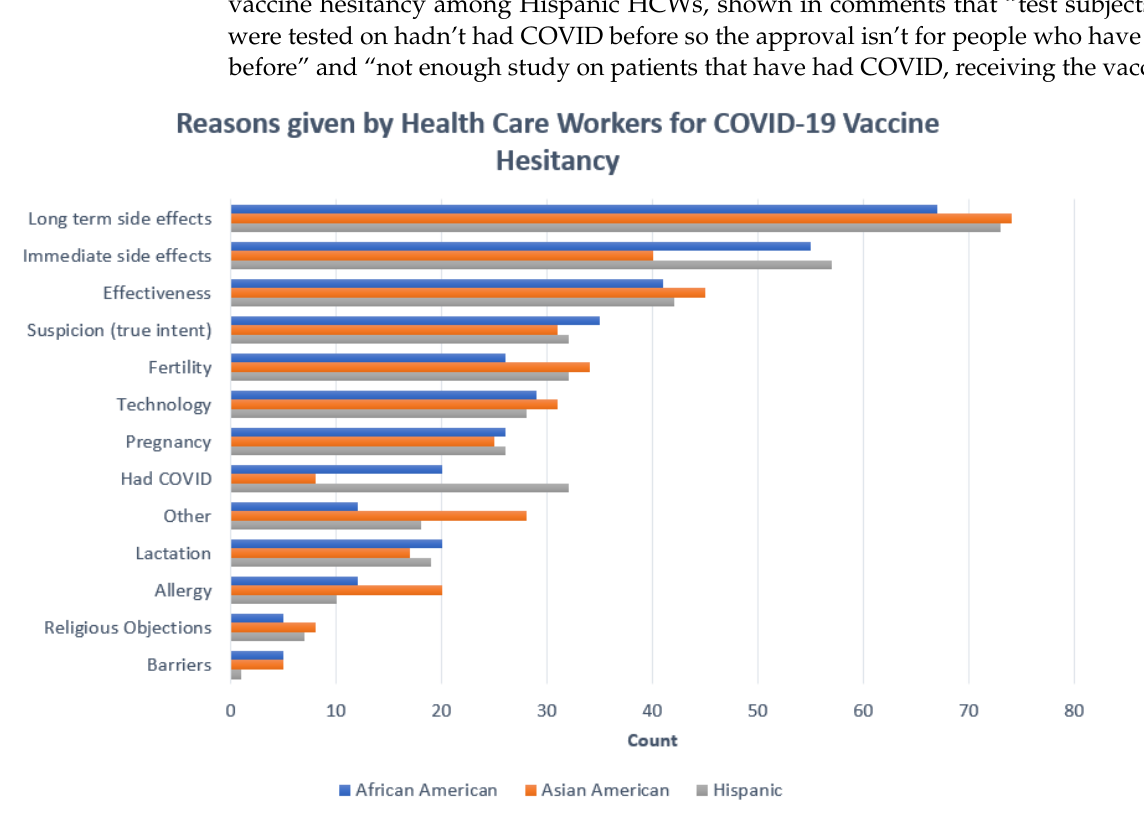
Figure 1. Ethnic variations in reasons given by health care workers for COVID ‐ 19 Vaccine Hesi ‐